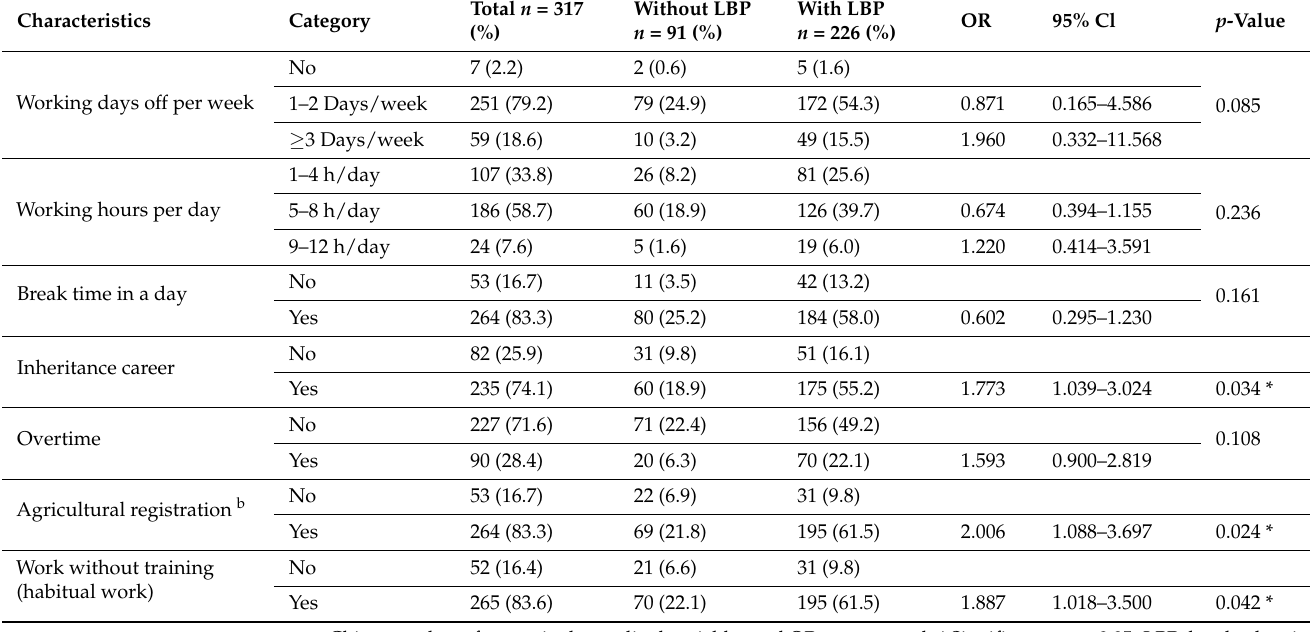
Table 2. Working profile of LBP predictors among rubber farmers ( n = 317).